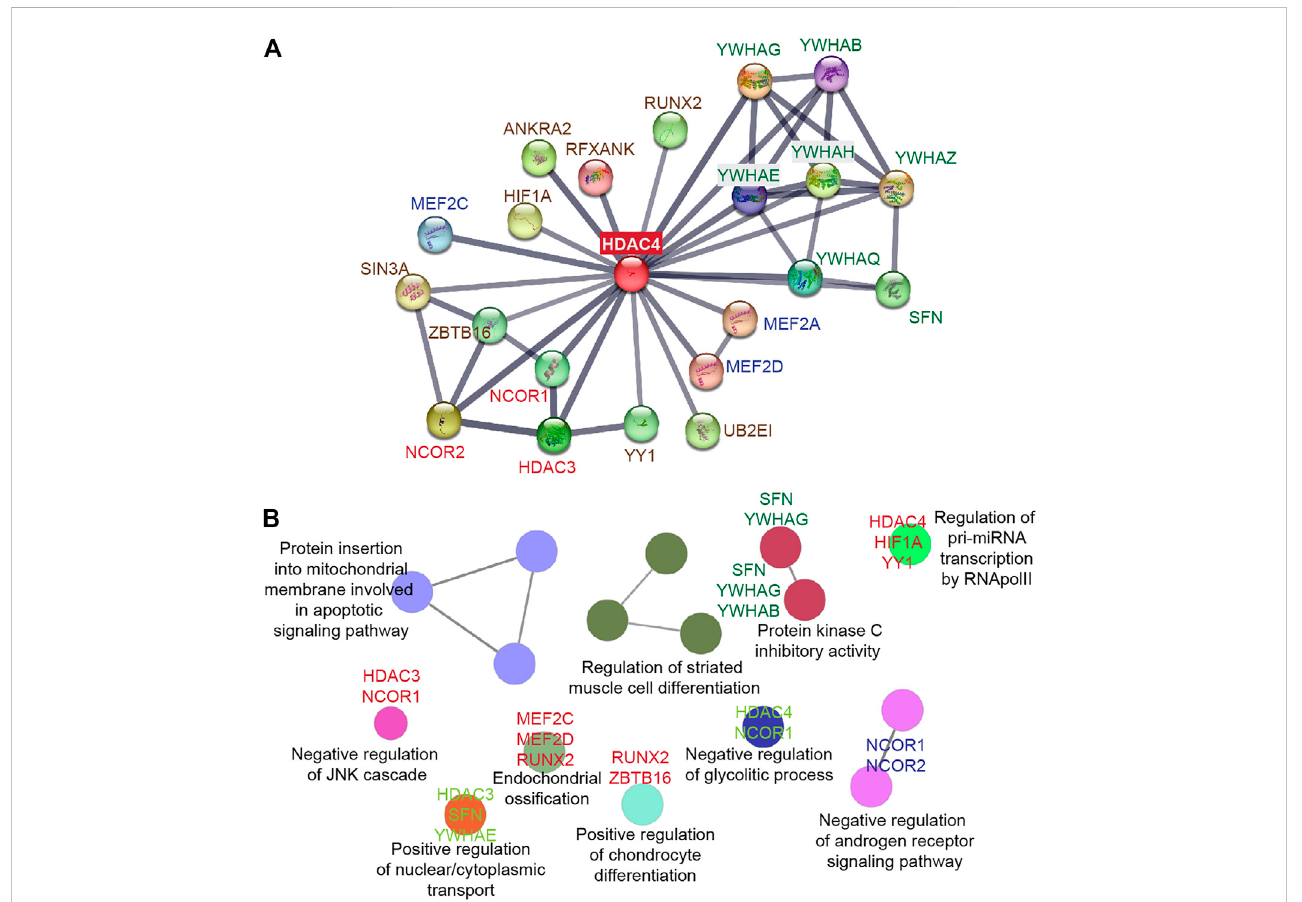
FIGURE 3 HDAC4 as a platform to orchestrate multiple protein interactions. (A) STRING protein-protein interaction (PPI) network (Szklarczyk et al., 2021) was created to capture HDAC4 molecular partners. (B) The biological functions of the HDAC4 partners were analyzed using the ClueGO plug-in from Cytoscape (Bindea et al.,